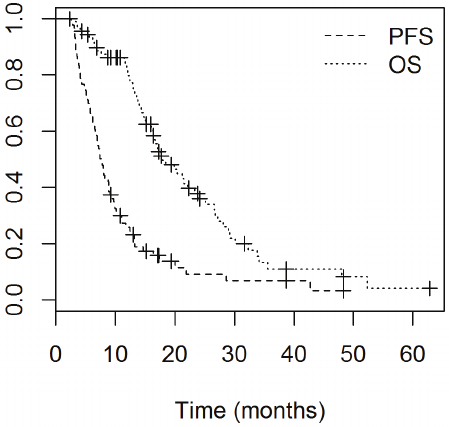
Tumor size. While previous analyses have shown that age and resection status are the primary prognostic factors for survival, tumor size and location are often prognostic in other tumor histologies. To explore the relationship of tumor size defined as the smallest quartile versus the largest quartile [10] and prognosis in GBM, calculated treatment planning volumes were compared to patient outcomes. Clinical variables for the small and large volumes are shown in Table 2. As shown in figure 2, using log rank analysis, patients with the smallest GTV1 tumors (GTV1 in the lowest 25 th percentile) had a median OS of 52.3 months compared to 16.3 months among patients with the largest tumors (GTV1 in the highest 25 th percentile), P=0.006 . Likewise, the median PFS was 12.5 months for patients with the smallest GTV1 tumors and 6.2 months for patients with the largest, P= 0.008 . On multivar- iate analysis using tumor volume, age, resection status and location, only tumor volume was statistically significant, P = 0. 02, Table 2. Similarly, the OS among patients with the smallest PTV1